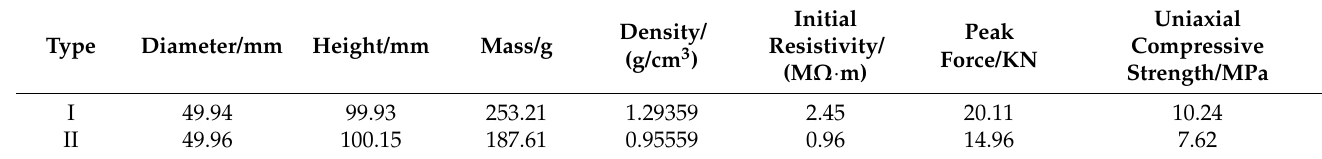
Table 1. Physical and mechanical parameters of coal